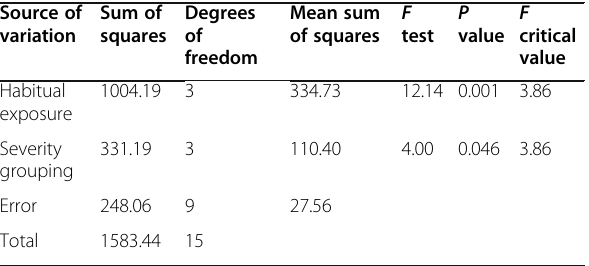
Table 12 ANOVA Two-way classification